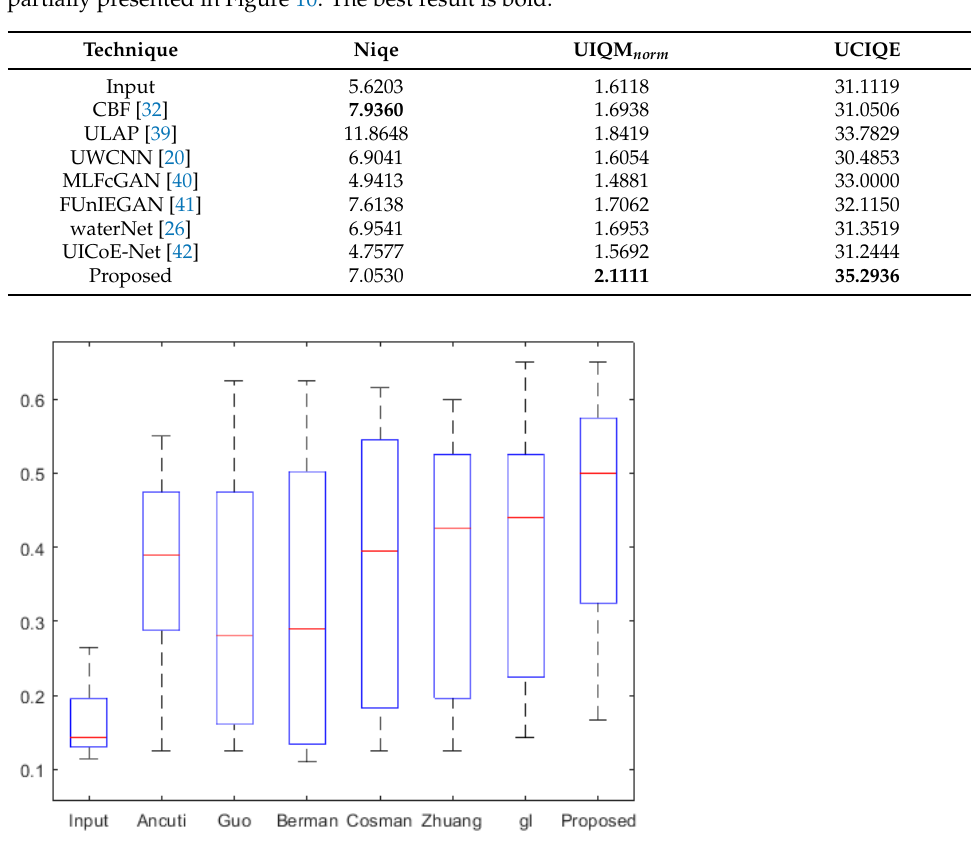
Figure 11. Box plot showing the performance of the proposed technique compared to the exist- ing